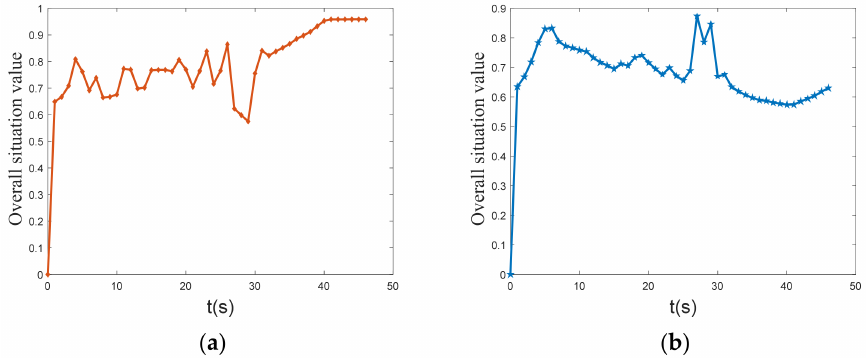
Figure 17. Overall situation value change curve. ( a ) UCAV; ( b ) enemy.